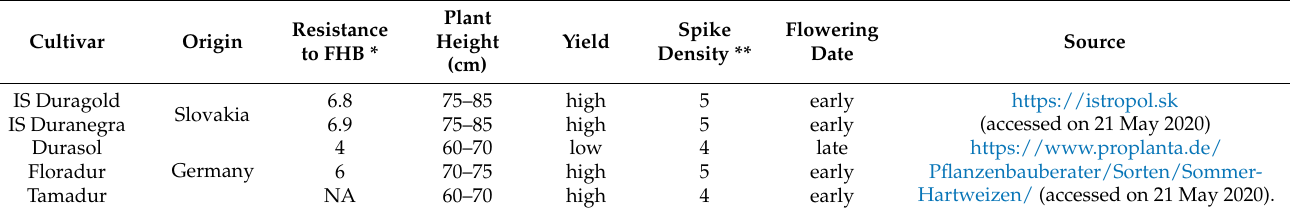
Table 2. Characteristics of spring durum wheat cultivars grown in two